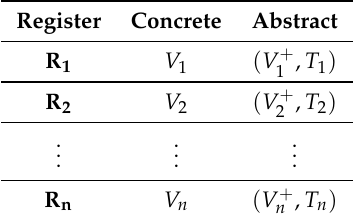
Table 1. Concrete versus Abstract model transformation.